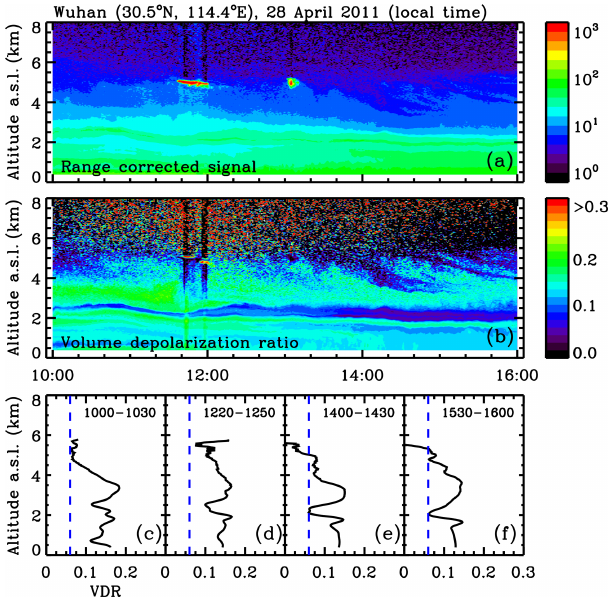
Figure 3. Time–height contour plots (1min/30m resolution) of (a) range-corrected signal and (b) volume depolarization ratio and 30min integrated profiles of volume depolarization ratio during (c) 10:00–10:30LT, (d) 12:20–12:50LT, (e) 14:00–14:30LT, and (f) 15:30–16:00LT measured by a 532nm polarization lidar on 28 April 2011. The vertical dashed blue lines indicate the volume depolarization ratio value of 0.06 that is considered as a threshold for the identification of dust